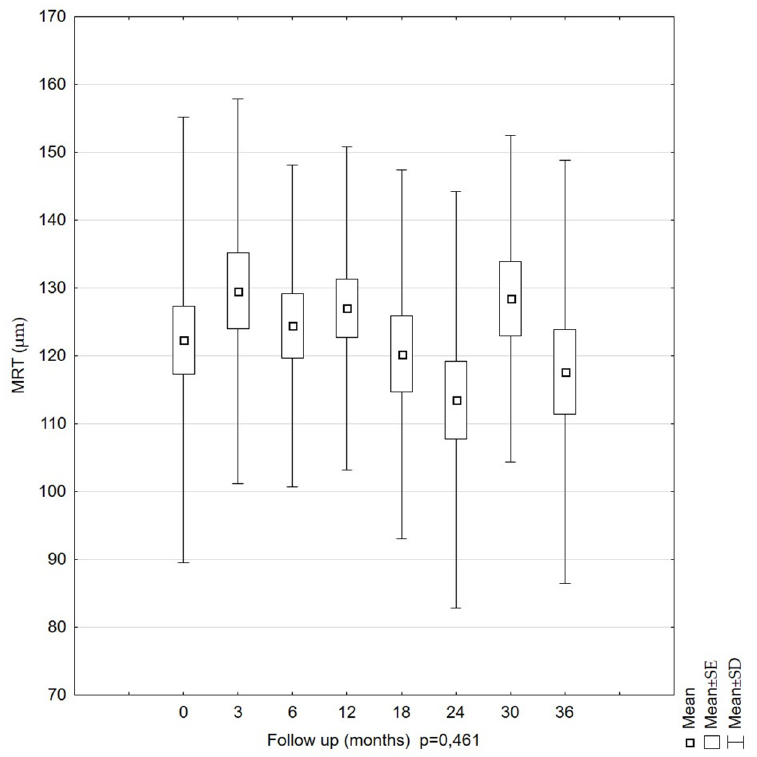
Figure 2. Mean minimal retinal thickness (MRT) values in LMH patients during the 36-month follow-up period. No significant changes were observed, showing that LMHs were stable over this period.